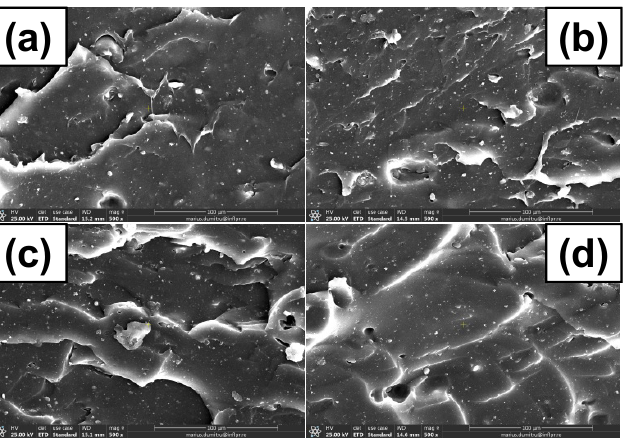
Figure 11. C10 SEM micrographs at magnification of 500: ( a ) un-irradiated, ( b ) irradiated at 150 kGy, ( c ) irradiated at 300 kGy, ( d ) irradiated at 450